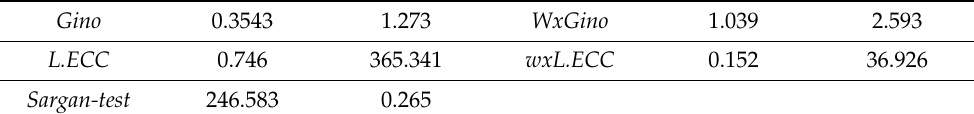
Table 8. System GMM Estimation